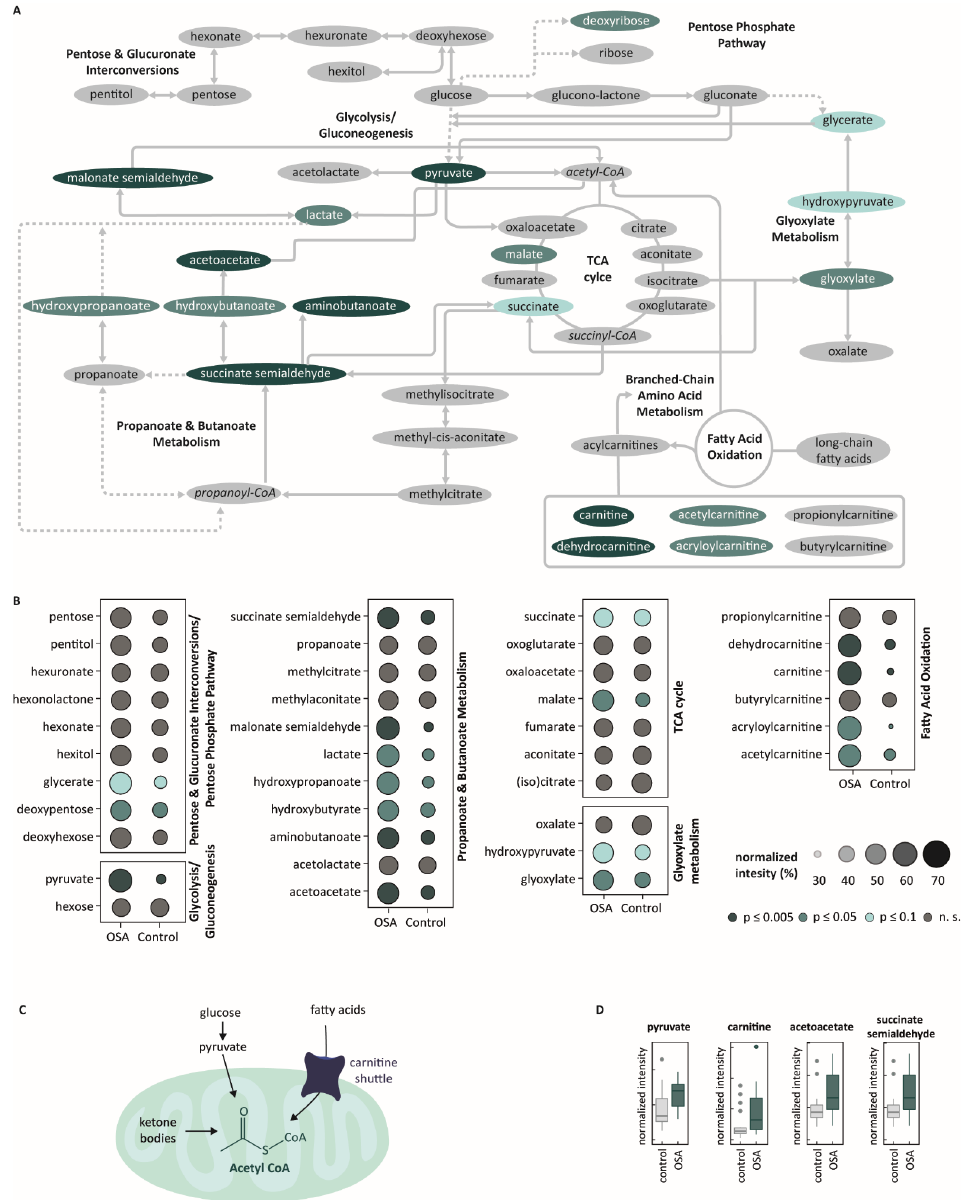
Figure 3. Sleep-stage-dependent metabolites in symptomatic OSA patients compared to controls. ( A ) Map of major metabolic pathways related to sleep architecture. All compounds on this map are vigilance-state-related (1). Metabolites that are elevated in OSA patients compared to controls are highlighted in green (dark green: p ≤ 0.005; green: p ≤ 0.05; light green: p ≤ 0.1). ( B ) Intensities of identified sleep-stage-dependent metabolites of major pathways in symptomatic OSA patients vs. control. Dot size represents intensity in %; colors indicate the level of significance of the differ- ence between the two groups (n.s.: not significant). ( C ) Schematic and hypothetical mitochondrial burnout due to sleep–wake disturbance in OSA. ( D ) Boxplots of elevated mitochondrial-metabolism- associated precursors in breath of OSA patients during daytime. Boxplots (center line: median; box limits: 25th and 75th percent quantile; whisker length: 1.5 interquartile